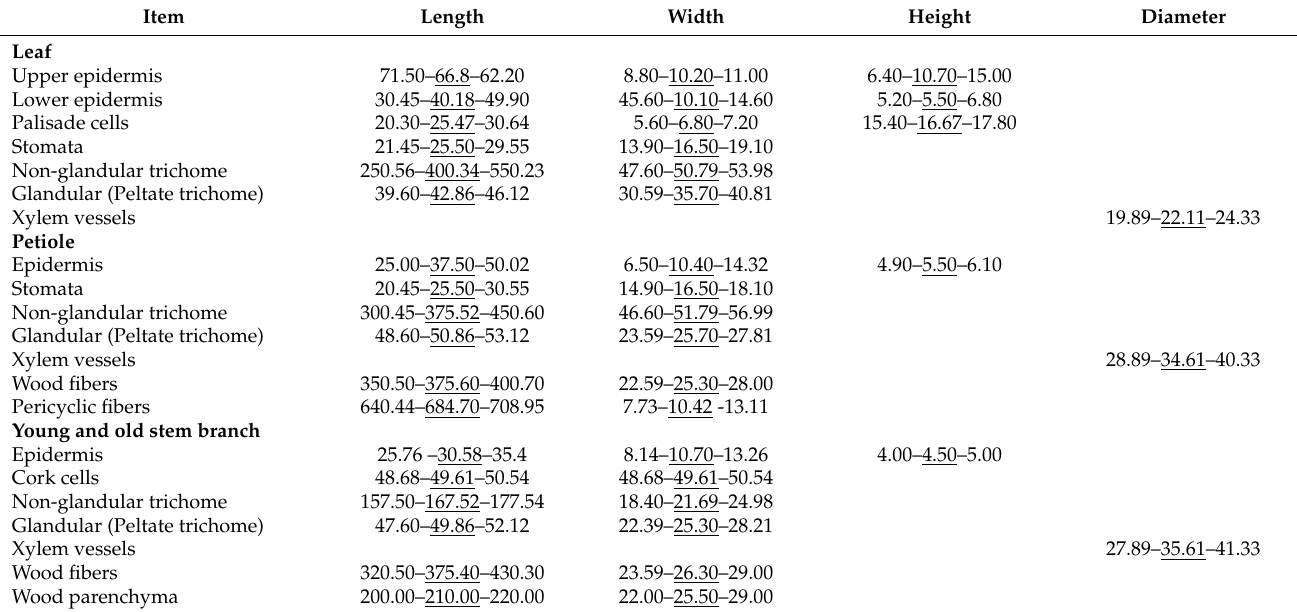
Table 1. The microscopical measurements of the various elements existing in the leaves, petiole and stems of P. odorata (in µ m).